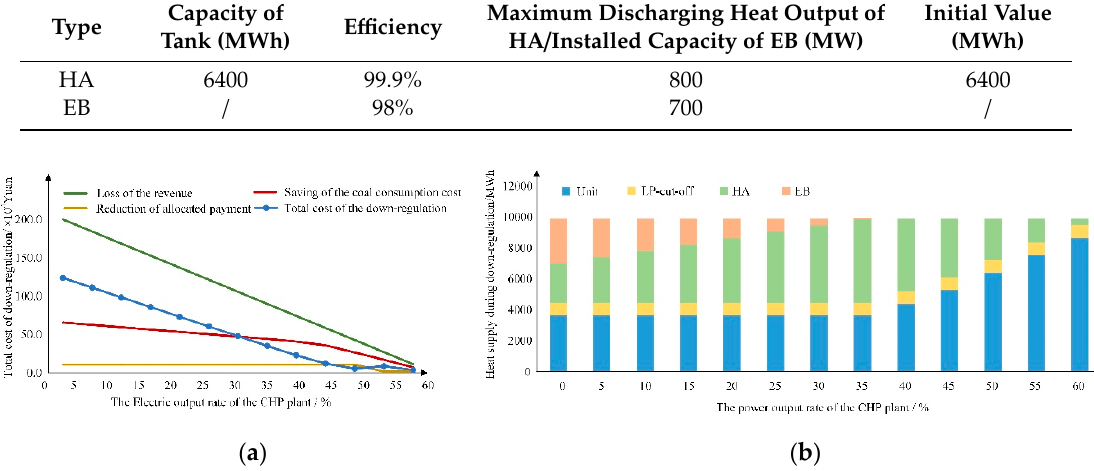
Figure 6. ( a ) Relationship between the total cost for down-regulation and power output rate of the CHP plant; ( b ) relationship between heat components and power output rate of the CHP plant.